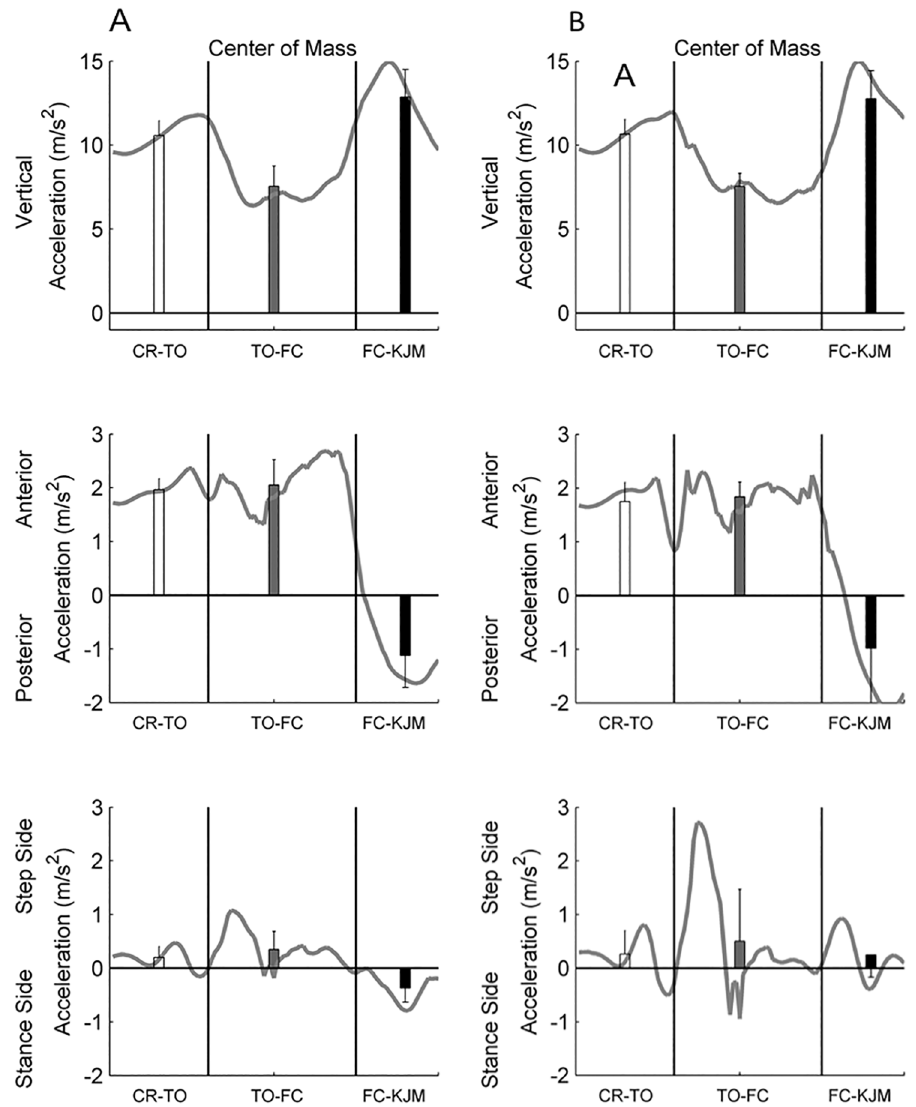
Fig 3. Instantaneous and mean COM accelerations for older adults (A) and younger adults (B) in the vertical, anterior-posterior and medial-lateral directions during balance recoveryfor the period from cable releaseand toe-off (CR-TO), toe-off to foot contact (TO-FC) foot contact to knee joint maximum (FC-KJM). Error bars represent one standard deviation.